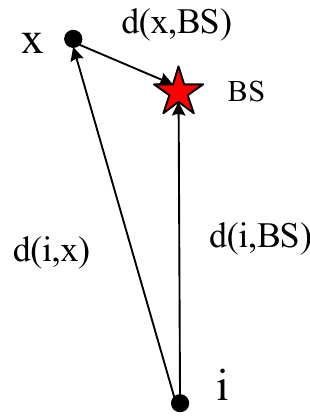
Figure 10. Schematic diagram of information transmission between nodes. BS—base station.